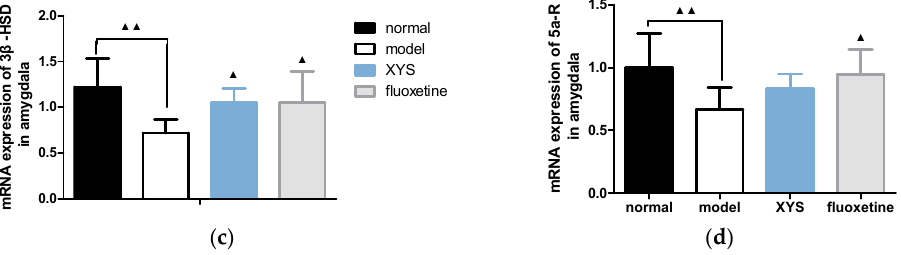
Figure 8. ( a ) mRNA expression of P450scc in amygdala; ( b ) 3a-HSD; ( c ) 3 β -HSD; ( d ) 5a-R. The data were expressed as mean ± standard deviation ( (cid:1876)̅ ± s), n = 10. ▲ p < 0.05, ▲▲ p < 0.01, compared with the model group.